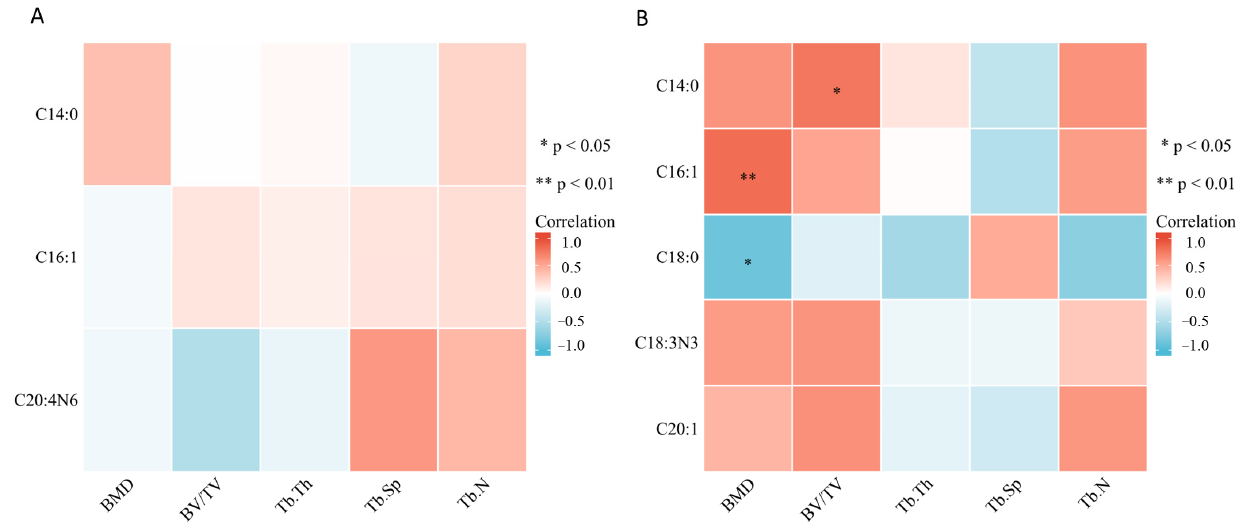
Figure 5. Correlation between differential fatty acids and bone microarchitecture parameters. ( A ) Correlation between differential fatty acids and bone microarchitecture parameters on the 3rd day after surgery. ( B ) Correlation between differential fatty acids and bone microarchitecture parameters on the 14th day after surgery. * p < 0.05 and ** p < 0.01 suggest a statistically significant correlation. Color key indicates the correlation coefficients, red: positive correlation, blue, negative correlation.